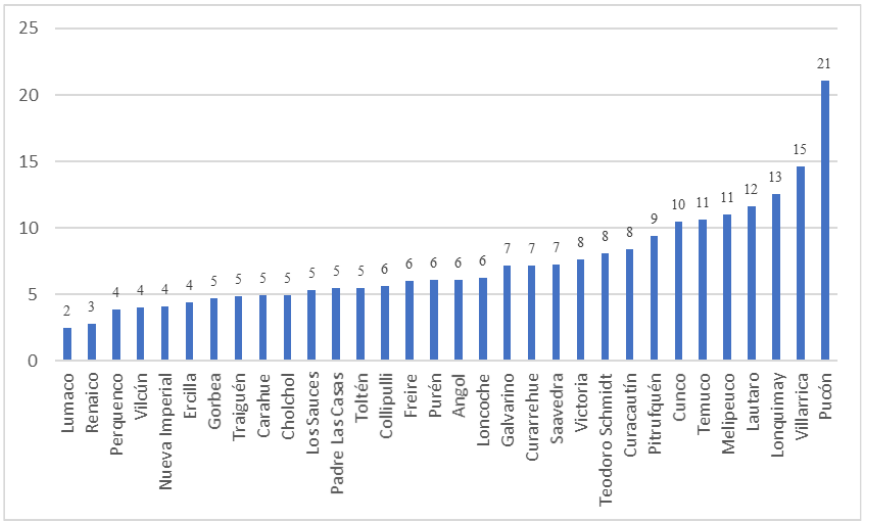
Figure 3. Average number of homes built per 1000 inhabitants during the period 2017–2021 in districts of the Araucanía Region. Source: compiled by the authors using data from the Urban Observatory, Ministry of Housing and Urban Development.